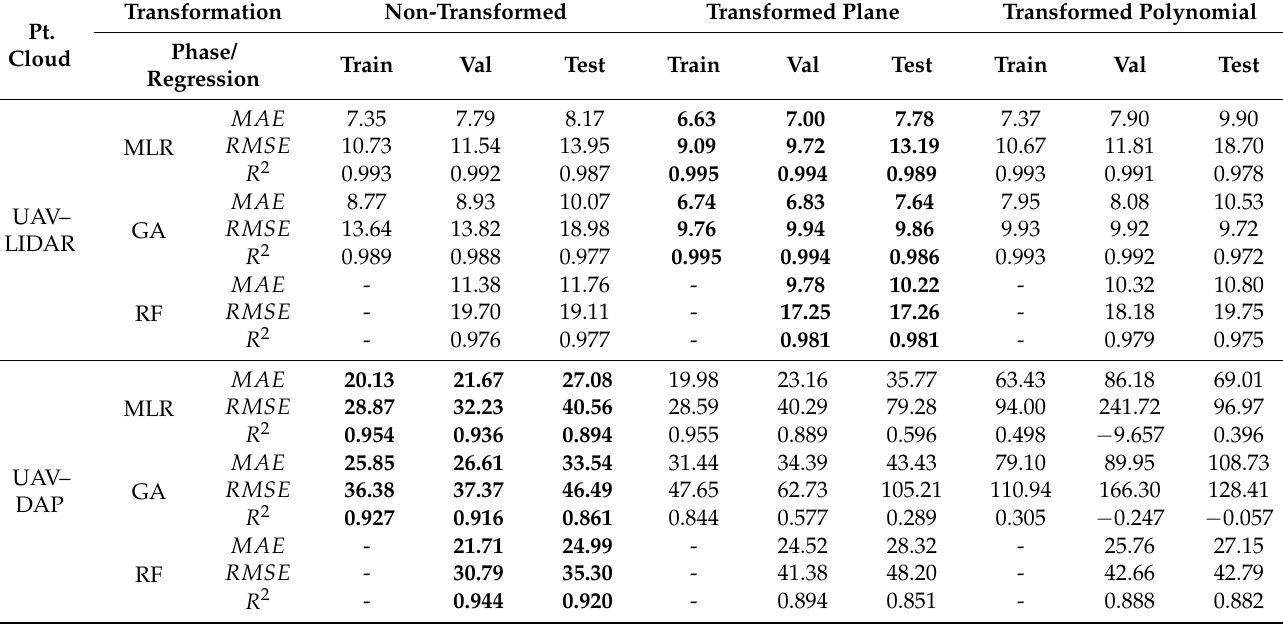
Table 2. The value of the evaluation metrics (i.e., MAE , RMSE , and R 2 ) we obtained in the training (Train), validation (Val), and test phase of the Monte Carlo cross-validation performed on the multi- variate linear regression (MLR), the genetic algorithm (GA), and the random forest (RF) methods. The evaluation metrics reported in the Train and Val columns are obtained by averaging those obtained from each permutation of the Monte Carlo cross-validation. Those reported in the Test column are obtained by applying the validated models on the test dataset (see Section 2.6). Evaluation metrics are calculated for every regressor, in the case they use the non-transformed point cloud, as well as the point cloud transformed using the planar and the polynomial surface (columns) as input to estimate the ground elevation in the study area. The bold underlined values indicate the lowest errors among those obtained from MLR, GA, and RF, in the various phases of the cross-validation. The values are identified for both the UAV–LIDAR and UAV–DAP point clouds. MAE and RMSE are expressed in